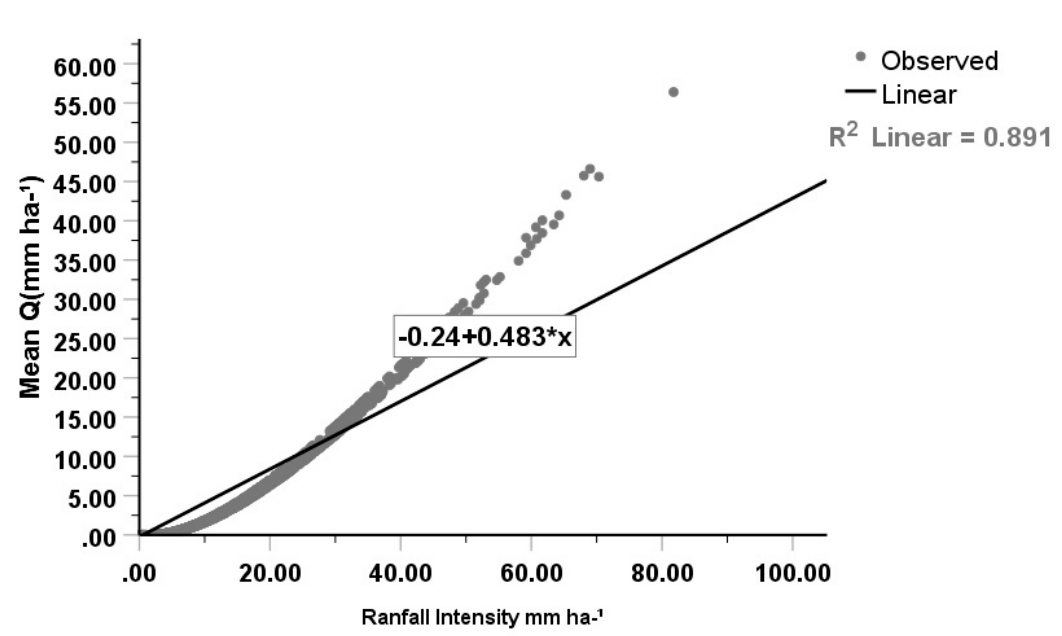
Figure 8. Annual rainfall dynamics in relationship to discharge and potential evapotranspiration (PET) (where Nprec is normalized precipitation, Qd is discharge, and NPET is normalized potential evapotranspiration).